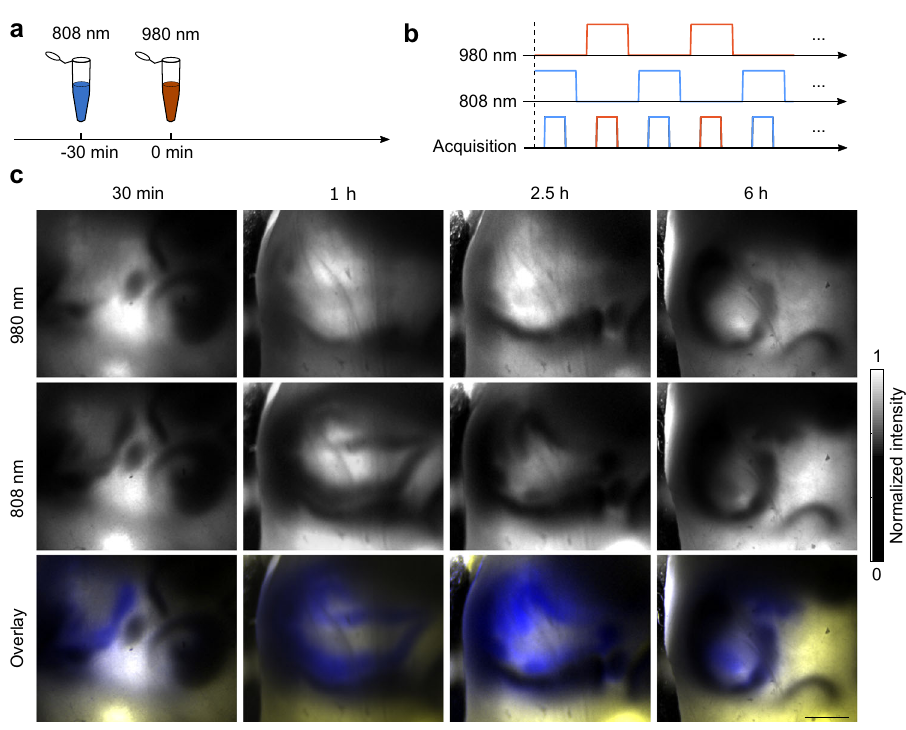
Fig. 6 Dual-contrast-agent intestinal imaging of mice revealed different sections of the intestine. a The 808 nm and 980 nm contrast agents were spectrally separate and were gavaged with a 30 min interval. b Schematic drawing shows the laser excitation and image acquisition sequences during dual- contrast-agent imaging. c The temporal intestinal images acquired at each wavelength (top and middle) and the overlay of the two images (bottom). Scale bar: 10 mm.